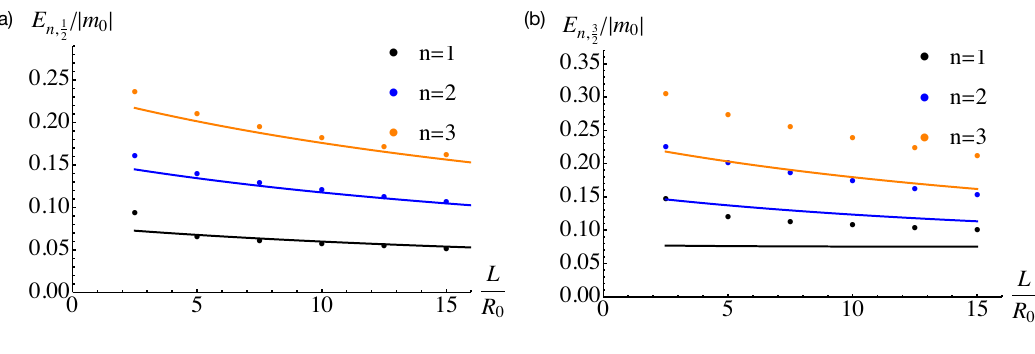
| of the surface states for a nanocylinder Figure 2: The quantised energy in units of | m 0 of radius R = 20 R as a function of the height L , for different values of the quantum 0 number n and j = 1 / 2 panel (a), and j = 3 / 2 panel (b). The filled circles correspond to the results of the numerical calculation with discretisation constants a = 0.05 R and a while the solid lines are obtained with the analytical z 0